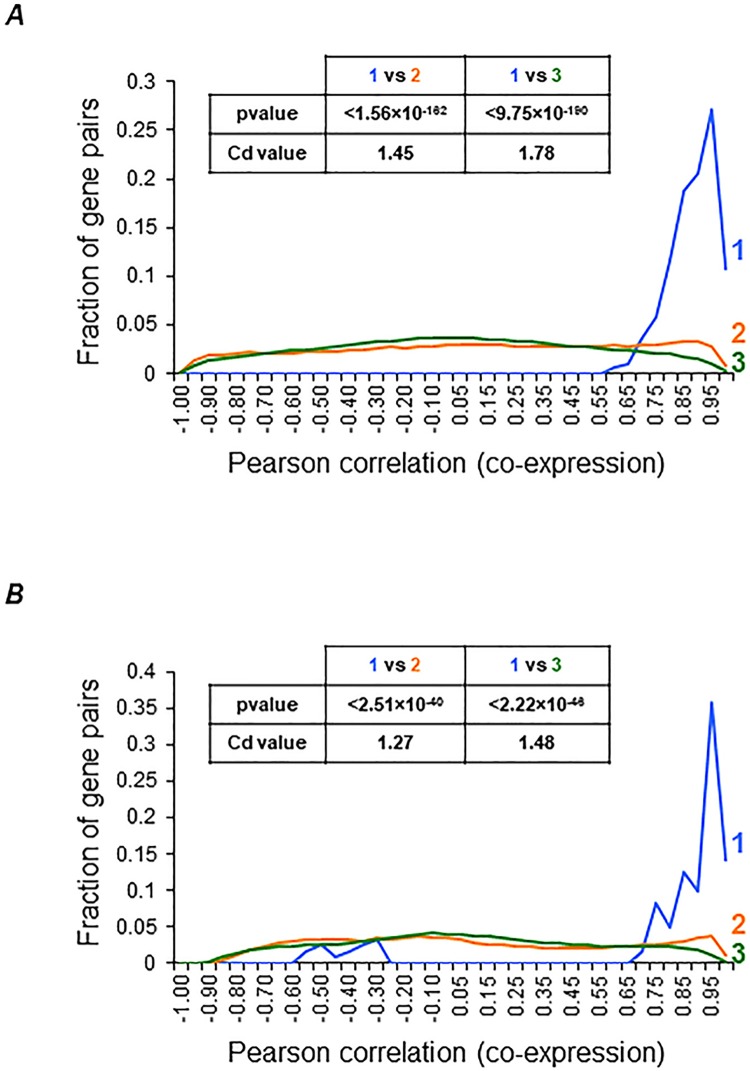
Gene coexpression analysis for T. gondii and P. falciparum F-type ATP synthase subunits.The distribution of coexpression values—as measured by the Pearson correlation coefficients—are plotted for the three gene pairs categories, as shown for T. gondii (A) and P. falciparum (B). The statistical support from MWU and Cd values are shown in the table within each plot. Blue (1), coexpression correlation between ATP synthase genes; Orange (2), coexpression correlation between ATP synthase genes and non-ATP synthase genes; Green (3), coexpression correlation between non-ATP synthase genes. MWU, Mann-Whitney U p-values; Cd, Cohen’s d.